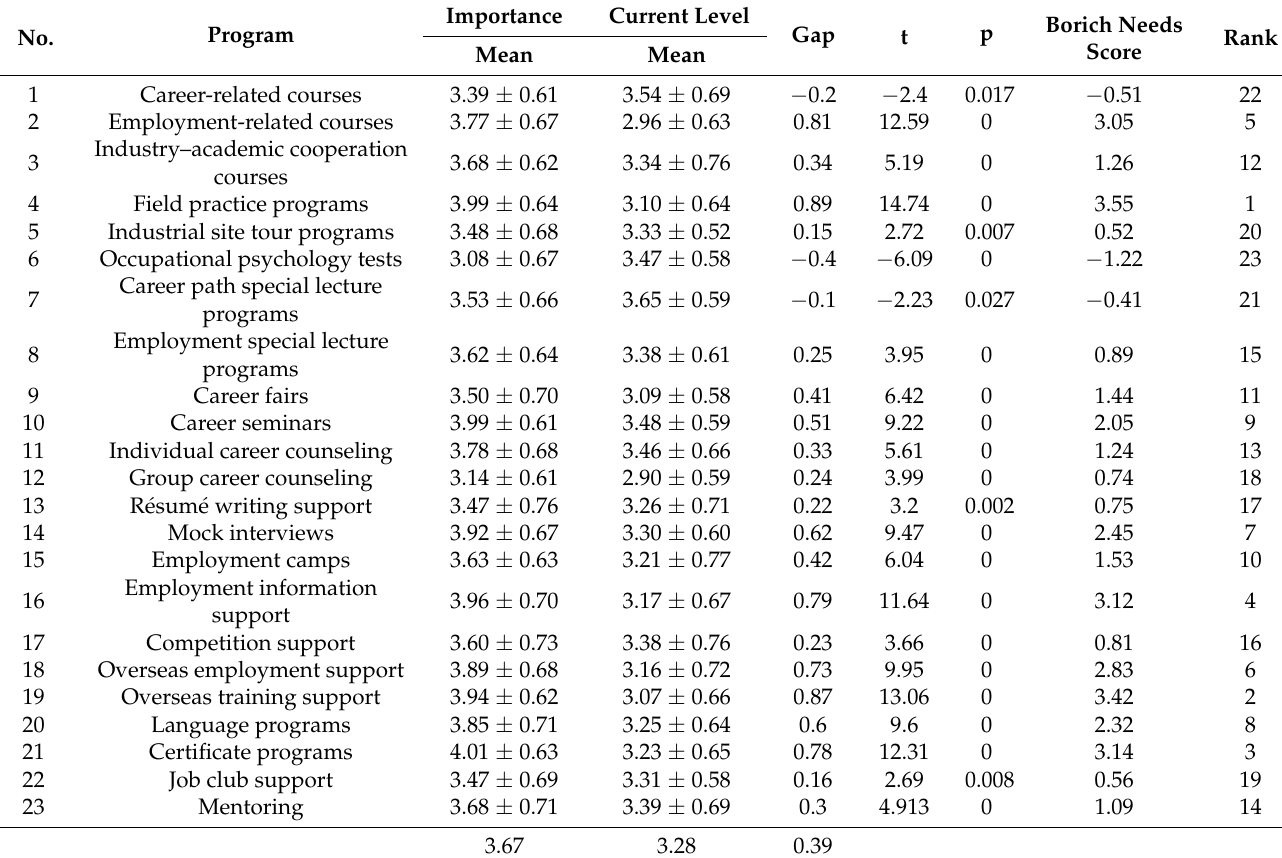
Table 3. Results of paired t-test analysis and Borich needs analysis for 4-year university